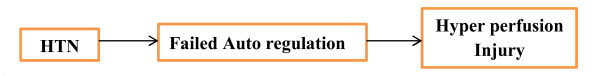
Most commonly attributed theory of PRES.